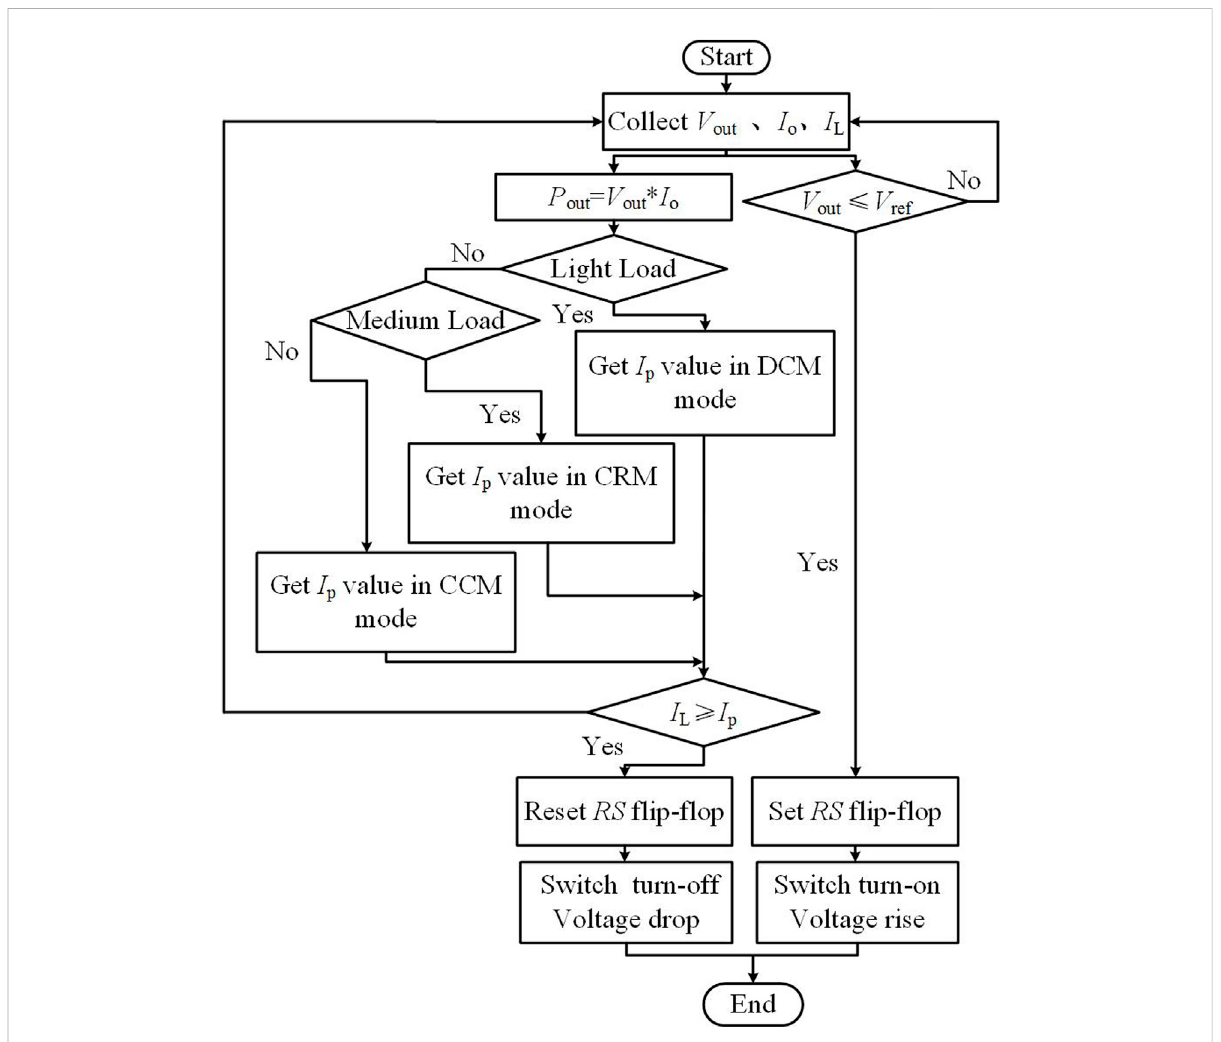
Block diagram of the variable amplitude/frequency